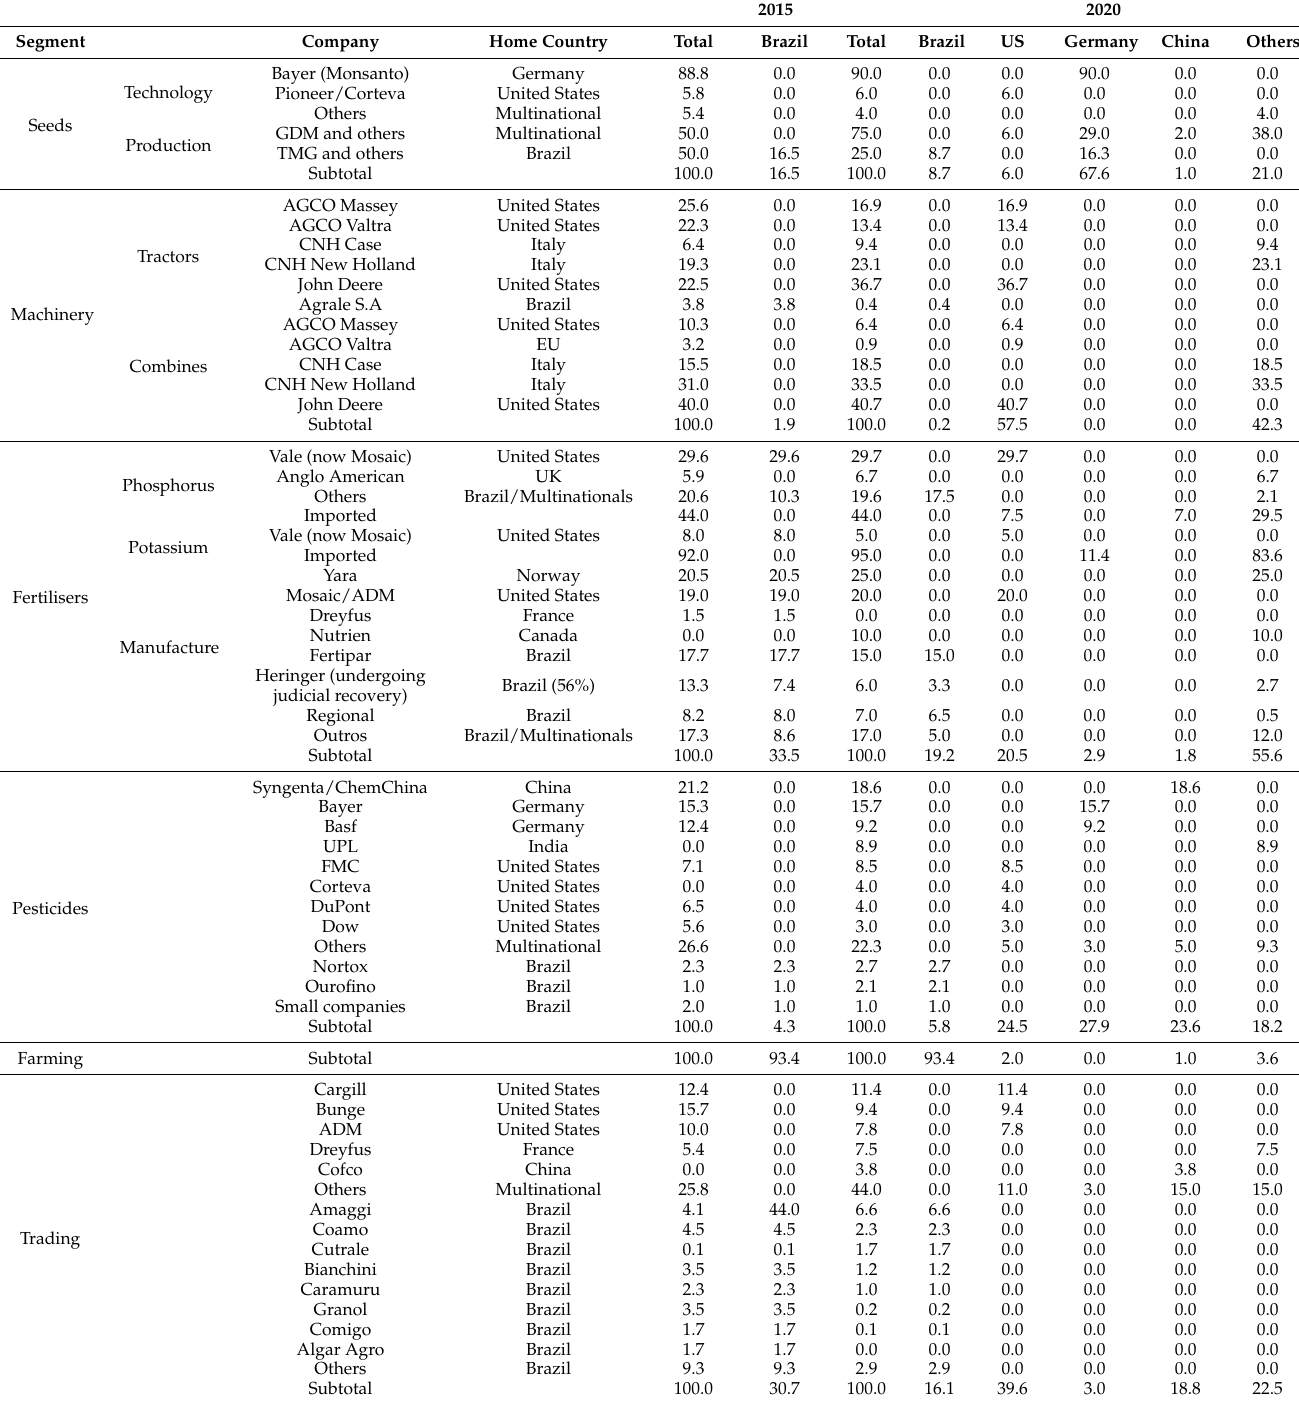
Table 2. Market share held by Brazilian vis à vis multinational companies in sectors of the soybean supply chain established in Brazil for the years of 2015 and 2020 (in